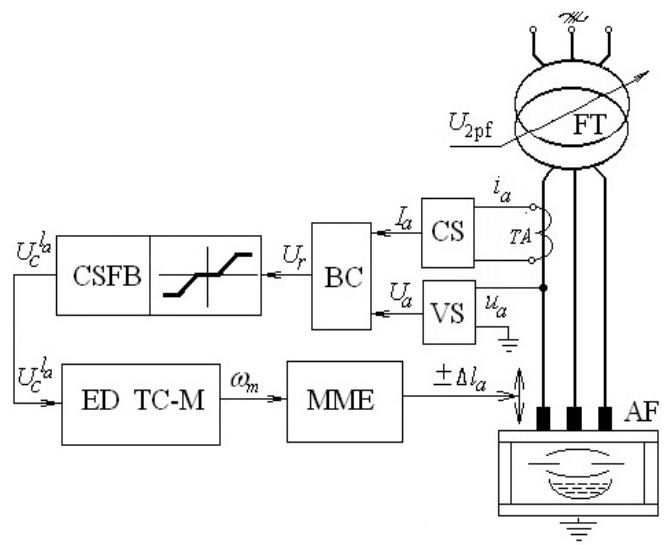
Figure 1. Functional single-phase block-scheme of ACS of the arc lengths of AF.